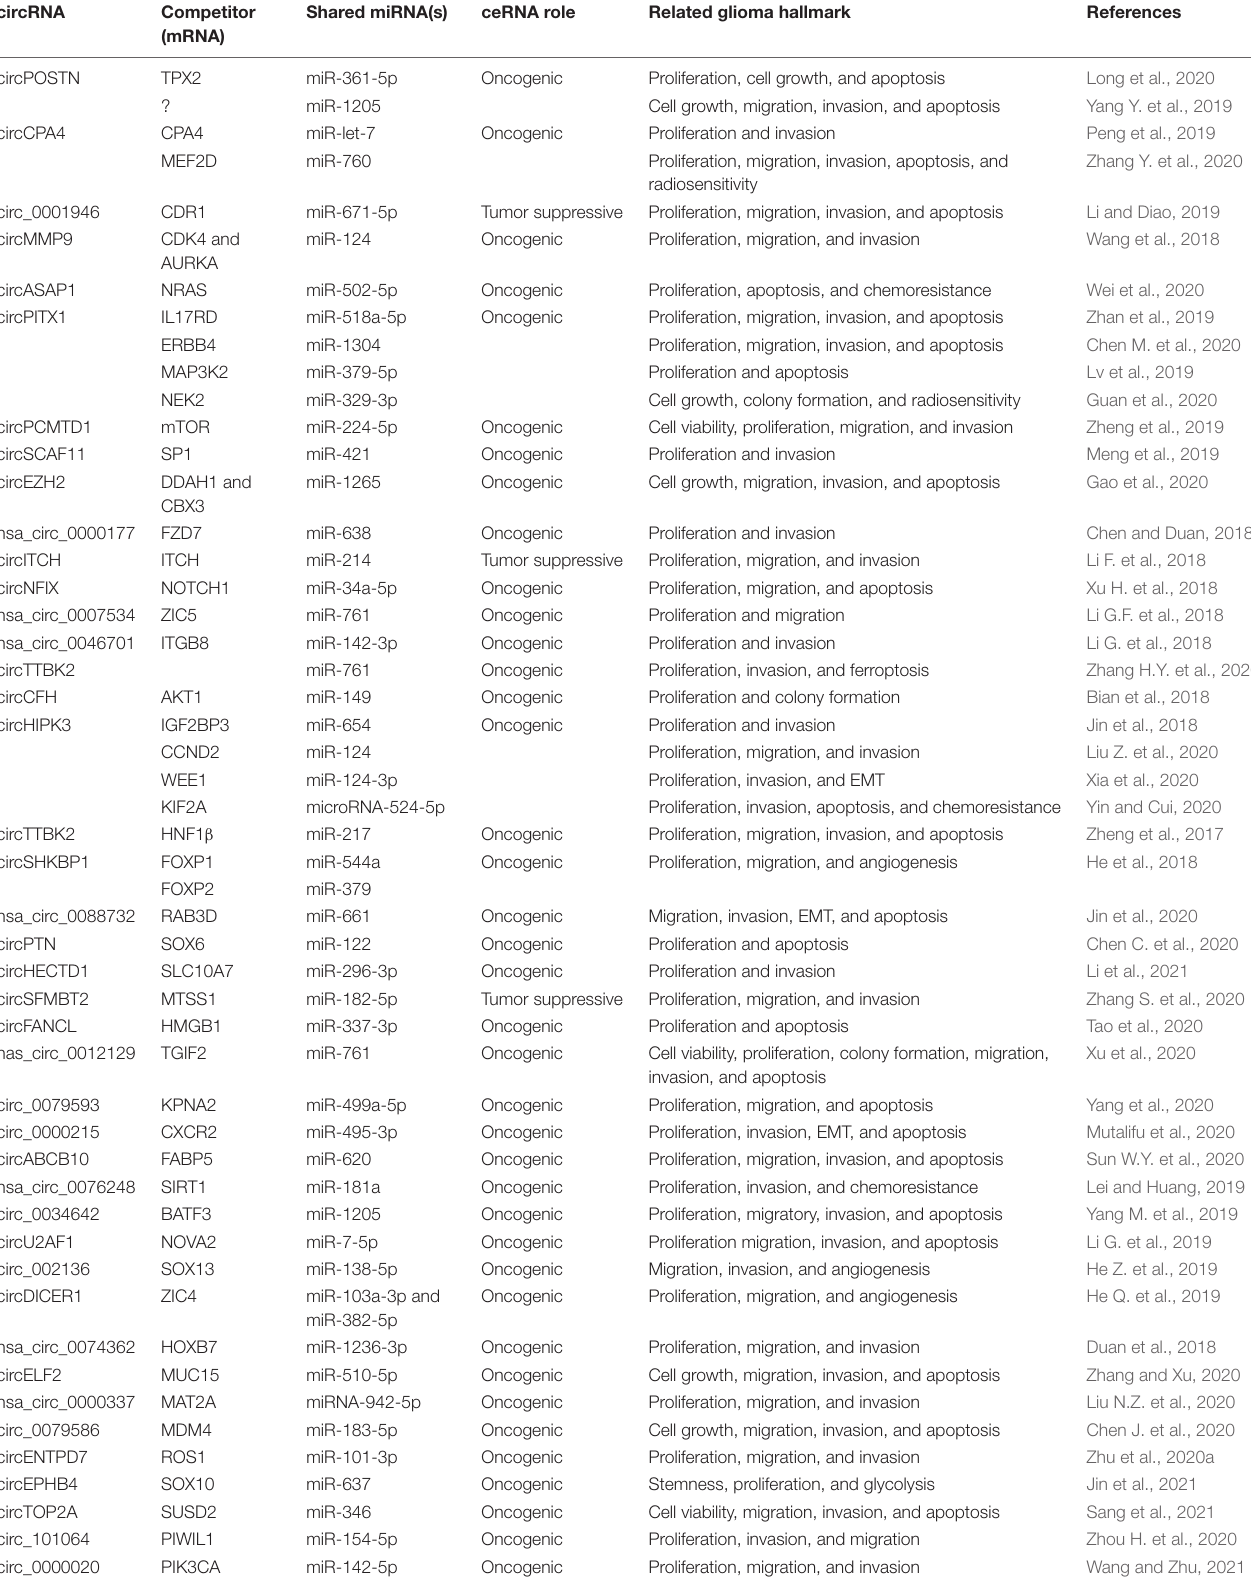
TABLE 2 | Representative circRNA-mediated ceRNETs in